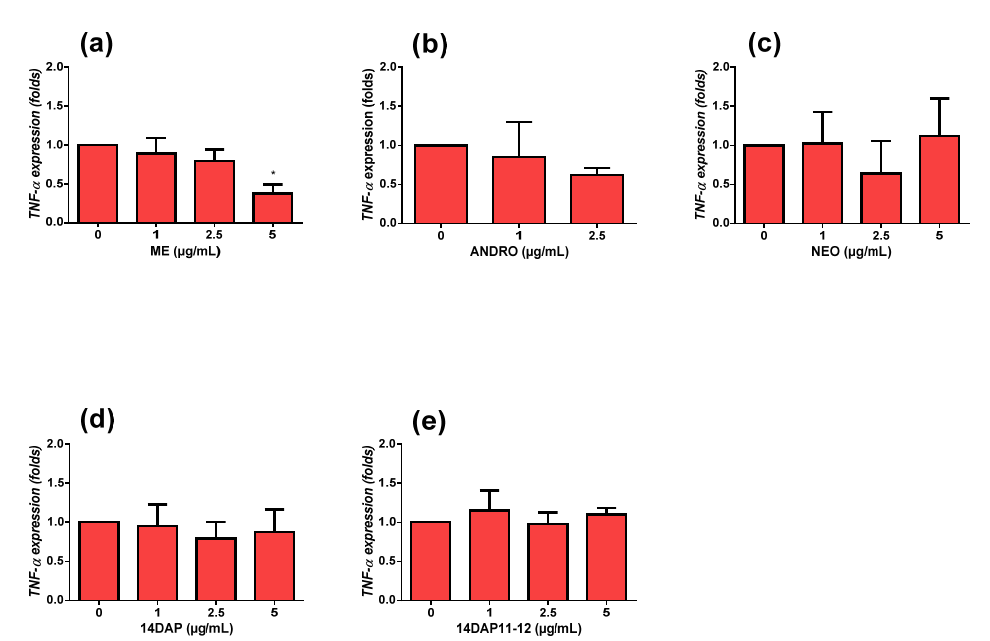
Figure 4. TNF- α expression and e ff ect of ME, ANDRO, NEO, 14DAP, and 14DAP11-12 in HaCaT Figure 4. TNF ‐α expression and effect of ME, ANDRO, NEO, 14DAP, and 14DAP11 ‐ 12 in HaCaT under pro-inflammation conditions. ME ( a ), ANDRO ( b ), NEO ( c ), 14DAP ( d ), or 14DAP11-12 ( e ) under pro ‐ inflammation conditions. ME (a), ANDRO (b), NEO (c), 14DAP (d), or 14DAP11 ‐ 12 (e) was was used at 1, 2.5, or 5 µ g / mL for 24 h. The control cells were treated with 0.05% DMSO (noted as used at 1, 2.5, or 5 μ g/mL for 24 h. The control cells were treated with 0.05% DMSO (noted as “0”). “0”). Inflammation conditions were induced by LPS (10 µ g / mL) for 6 h and TNF- α expression was Inflammation conditions were induced by LPS (10 μ g/mL) for 6 h and TNF ‐α expression was determined by RT-qPCR. The values are mean ± SD, * p < 0.05 compared with control group, n = determined by RT ‐ qPCR. The values are mean ± SD, * p < 0.05 compared with control group, n = 3. 3. Abbreviations: LPS, lipopolysaccharides; RT-qPCR, reverse transcription-quantitative polymerase Abbreviations: LPS, lipopolysaccharides; RT ‐ qPCR, reverse transcription ‐ quantitative polymerase chain reaction; TNF- α , tumor necrosis factor- α . chain reaction; TNF ‐α , tumor necrosis factor ‐α .